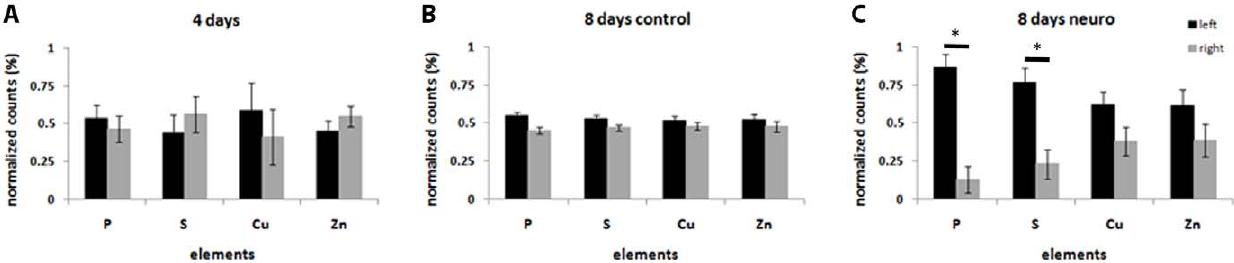
Figure 4. P and S polarization is significant on 8 days old neural induced murine embryoid bodies. Left and right intensity of P, S, Cu and Zn in R1 embryoid bodies. A) 4 days old group; B) 8 days old control group; C) 8 days old neural induced group. Left side is represented by black bars and right side is represented by grey bars, *p , 0.05.